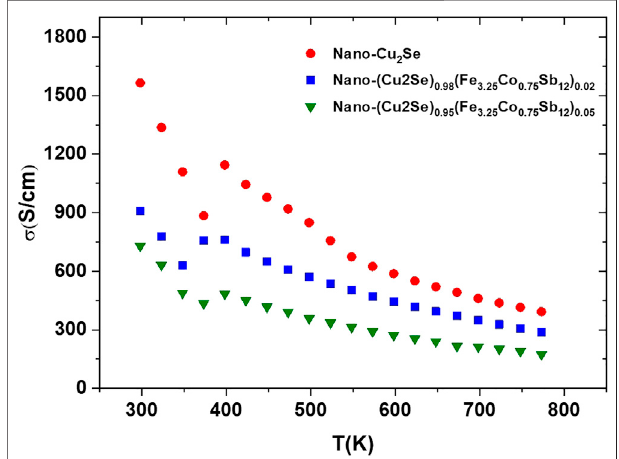
FIGURE 6 | Electrical conductivity vs. temperature for nano-Cu